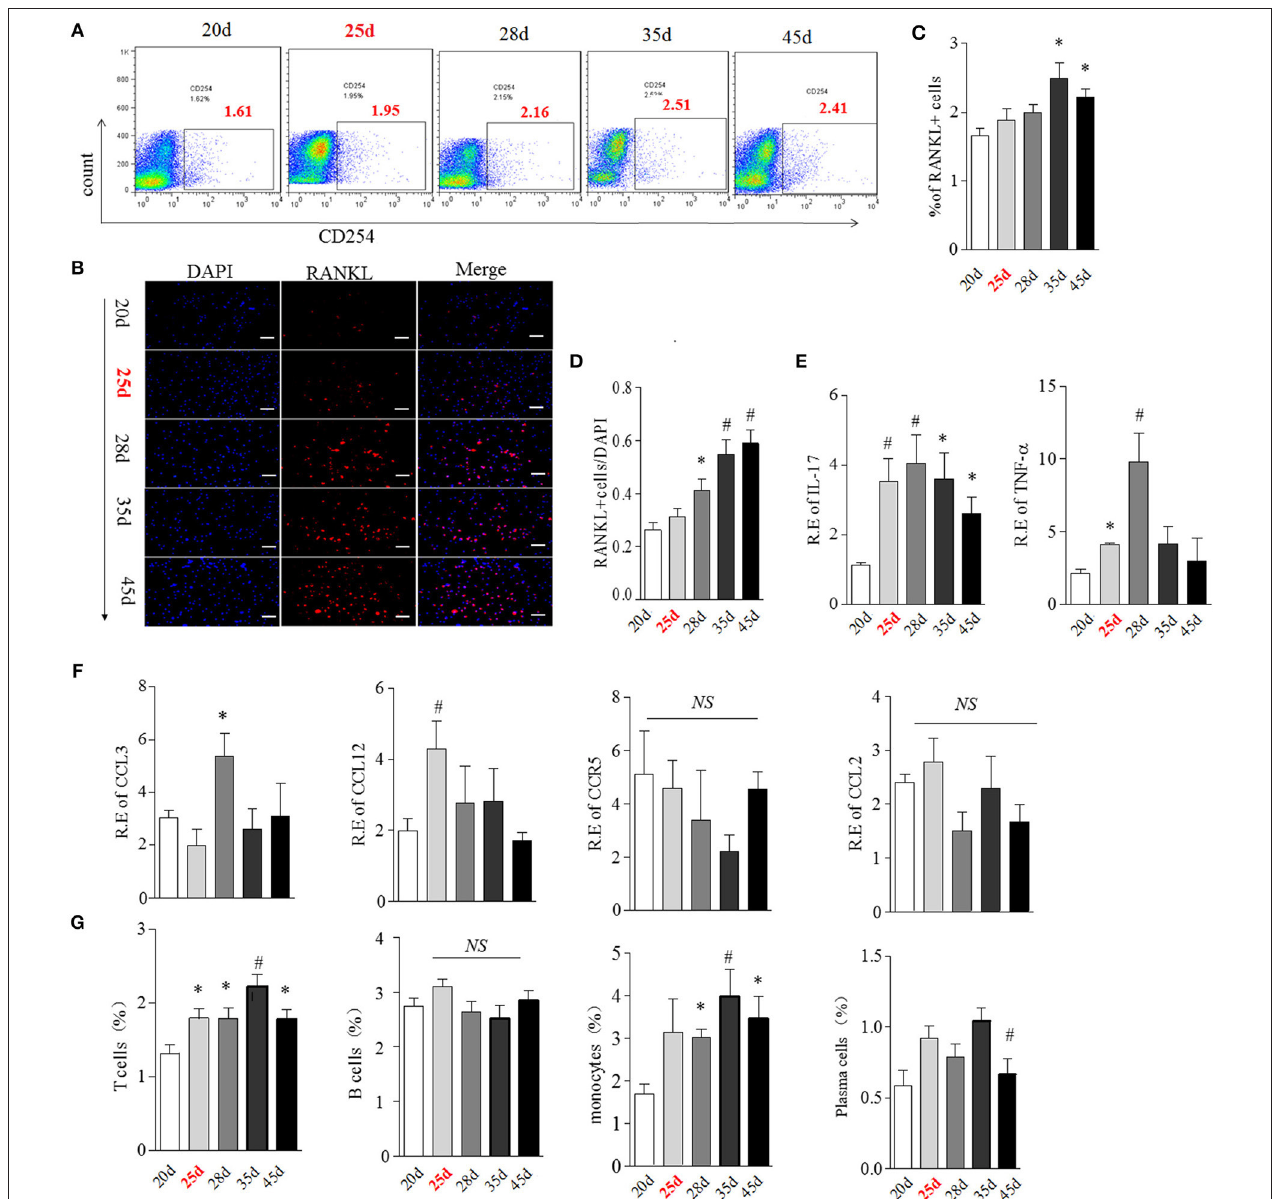
FIGURE 6 | BME links to the increased RANKL, OCs-related cytokines and immune cells expression in bone marrow during the development of CIA. (A,B) Expression of RANKL in bone marrow cells detected by flow cytometry (A) and immunofluorescence staining (B) . (C,D) Graphs show the quantitation data from image A (C) and B (D) . (E) Expression of IL-17(left) and TNF α (right) in bone marrow cells detected by Real-time PCR. (F) Expression of CCL3, CCL4, CCL12, and CCR5 in bone marrow cells detected by Real-time PCR. (G) Expression of T cell, B cell, plasma cell and monocyte in bone marrow cells were detected by flow cytometry. n = 5 at each indicated time point. Values are means ± SD (* p < 0.05, # p < 0.01, compared with day 20). All experiments were repeated three